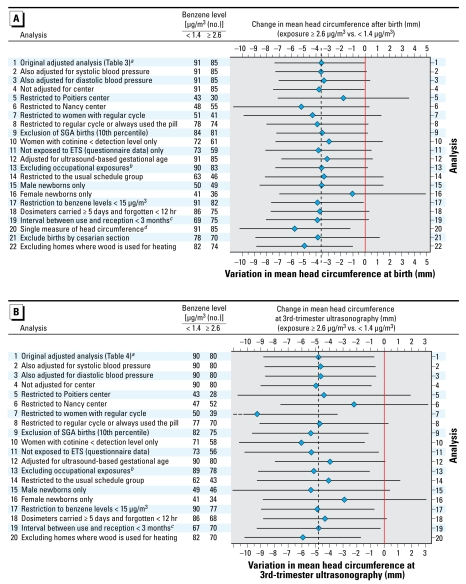
Sensitivity analysis: estimated effect of benzene levels (≥ 2.6 μg/m3, the reference being < 1.4 μg/m3) on head circumference after exclusion of specific subgroups of the population or adjustment for additional variables. Diamonds indicate point estimates; horizontal lines indicate the 95% CIs. Abbreviations: ETS, environmental tobacco smoke; SGA, small for gestational age. (A) Benzene and head circumference after birth (average of two measurements). (B) Benzene and head circumference at the third trimester (29–36 gestational weeks) ultrasound examination. aThe sample sizes correspond to the adjusted analyses and thus slightly differ from those given in Table 3 or Table 4. bExclusion of women occupationally exposed to paints or pesticides. cExclusion of air samplers stored for ≥ 3 months during any period including a day in the warm season (June–September). dThe single measure of head circumference performed right after birth was used instead of the average of the two independent measures performed shortly after birth.